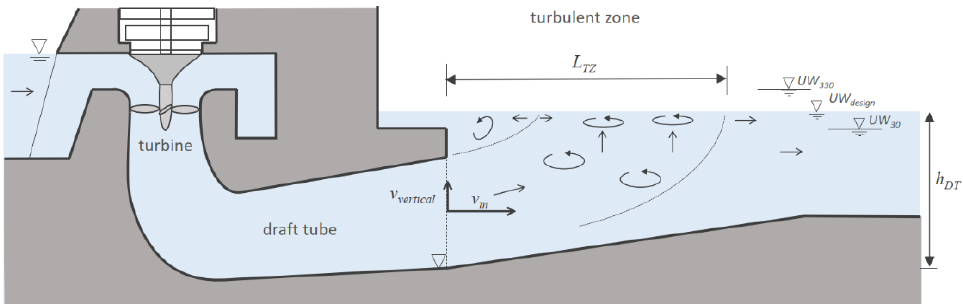
Figure 3. Schematic longitudinal section of the turbulent zone in a tailrace downstream of a vertically mounted Kaplan turbine with elbow draft tube; L TZ = length of the turbulent zone; v vertical = vertical velocity; v m = bulk mean velocity at draft tube exit section; tailwater levels UW 30 , UW 330 with 30 and 330 days of nonexceedance and UW design at design discharge of HPP; h DT = water depth at draft tube exit